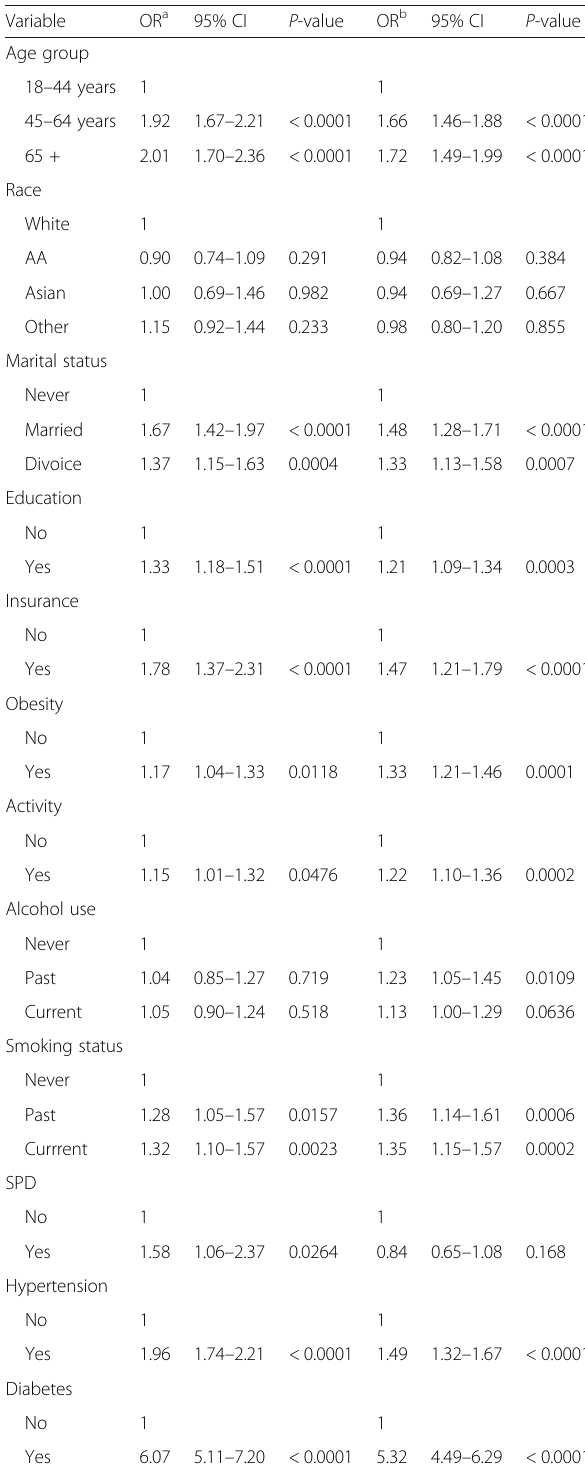
Table 3 Multiple logistic regression analysis for the relationship between potential factors and type 2 diabetes screening by gender